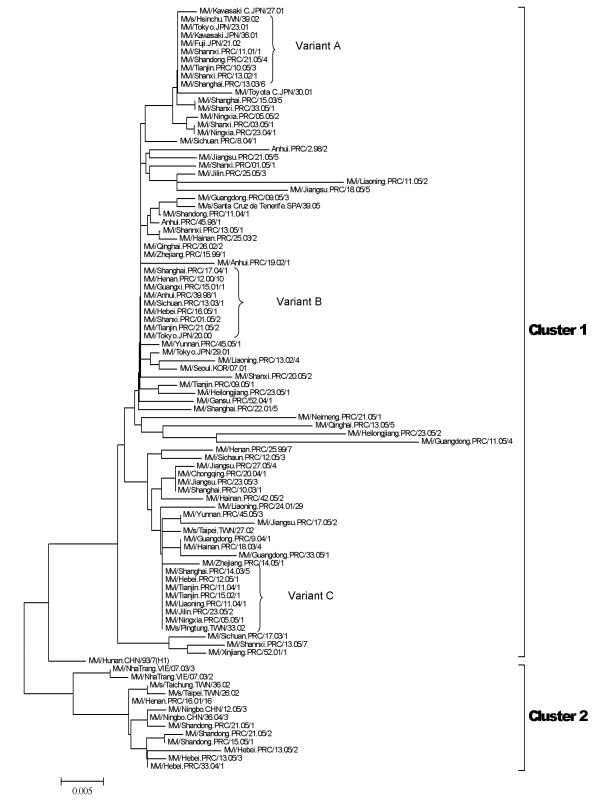
Phylogenetic tree of Chinese representative MV strains from 1993 to 2005 and the representative MV strains of H1 genotype based on the 456 nucleotide sequences coding for the COOH-terminus of the nucleoprotein. Three main variants (A, B and C) of cluster 1 genotype with the identical sequence for each variant were identified in mainland and Taiwan of China and Japan from 2000-2005. MeV strains of variant A were isolated from both China and Japan, 2000-2005. Variant B and variant C caused the measles continuous circulation in Mainland China and Japan from 2000-2005, and in Mainland and Taiwan China from 2002-2005, respectively. Sequences of Taiwan, South Korea, Japan and Vietnam obtained from GenBank, GenBank accession numbers are also shown for each strain.